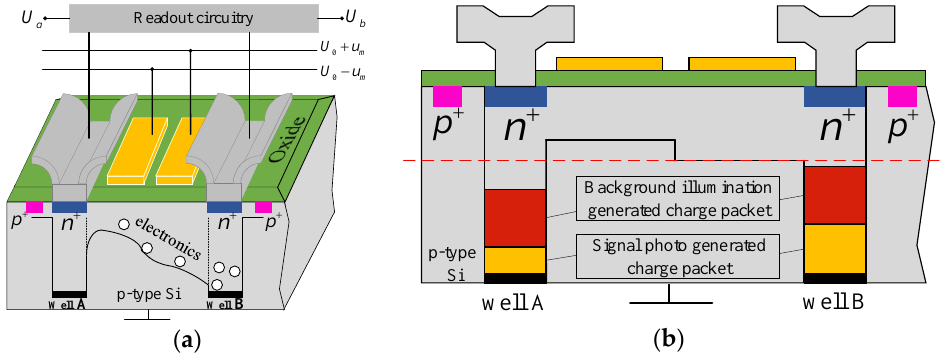
Figure 6. The structure diagram of the PMD and the schematic diagram of the influence of background light on the PMD. ( a ) The structure diagram of the PMD; ( b ) the schematic diagram of the influence of background illumination on the PMD.